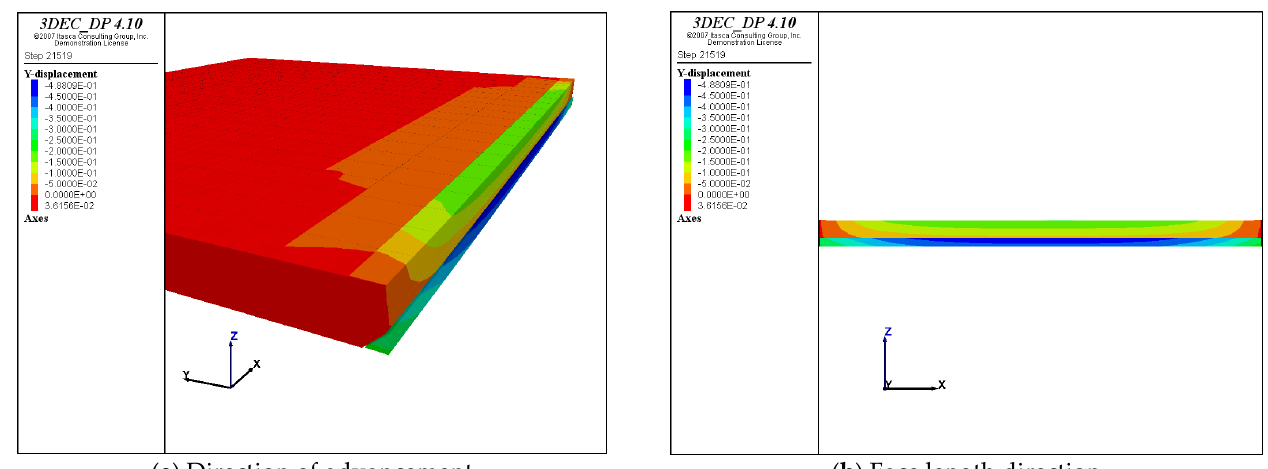
Figure 16. Y-displacement nephogram ( α = 135°).